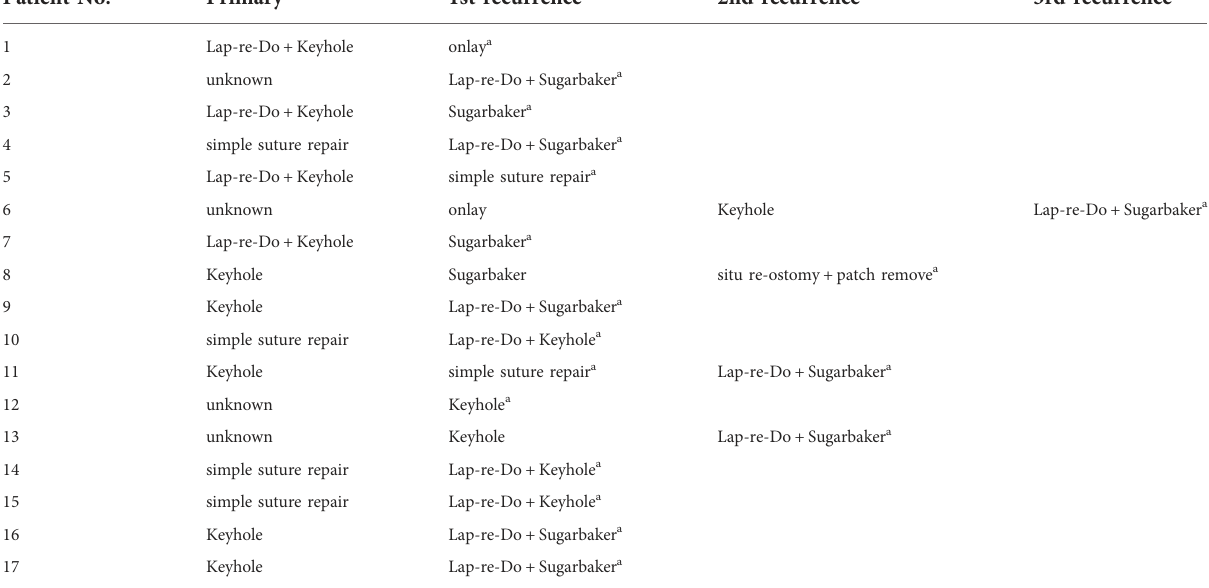
TABLE 2 Recurrent surgery techniques we used. Patient